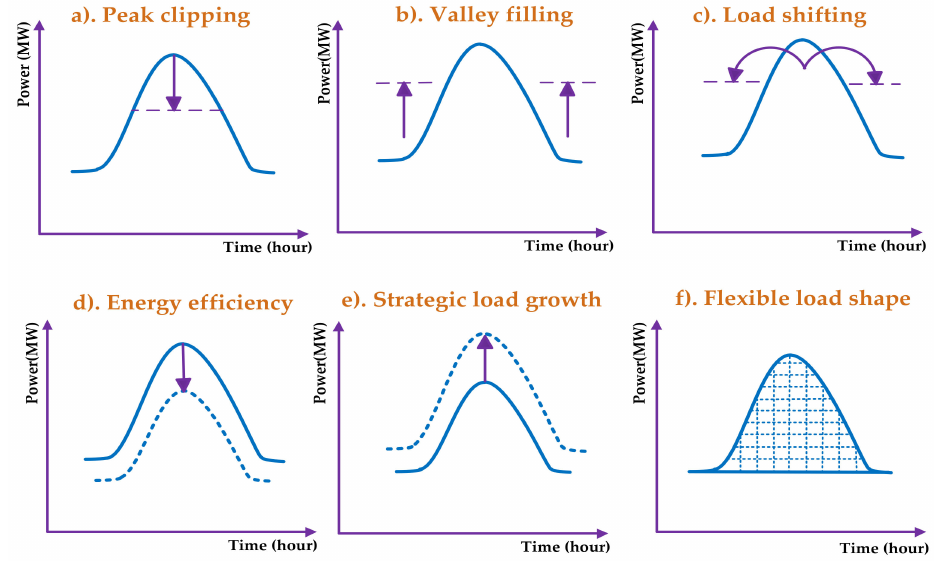
Figure 5. Various DSM